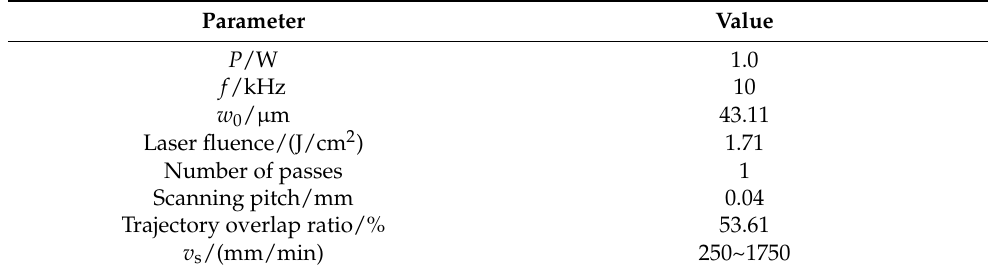
Figure 2. Schematic view of scanning trajectory and polished area planning. ( a ) The polished area planning; ( b ) The scanning trajectory. Table 2. Detailed parameters of coupled laser polishing operations.